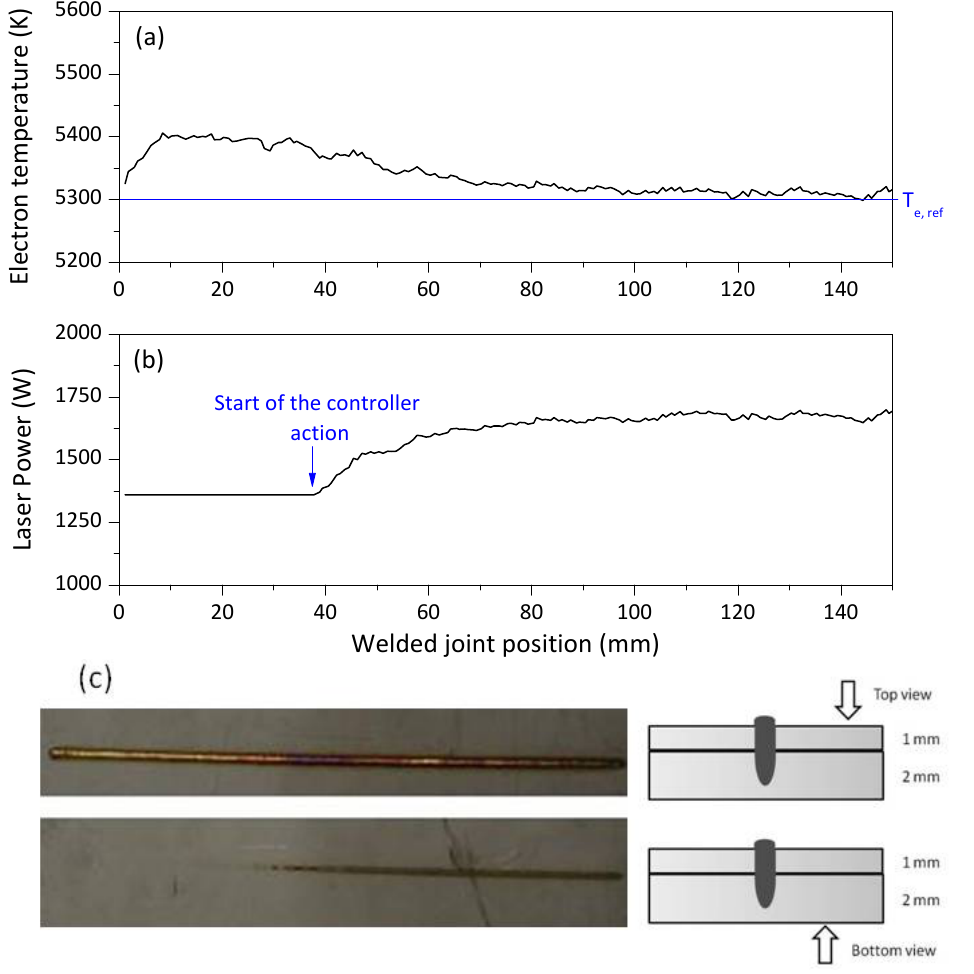
Figure 7. ( a ) Electron temperature signal behavior. Controller parameters: T corresponding to a (full) penetration depth of 3 mm; K laser power = 1,450 W. ( b ) Laser power measured by fast power sensor. ( c ) Top and bottom view of the welded